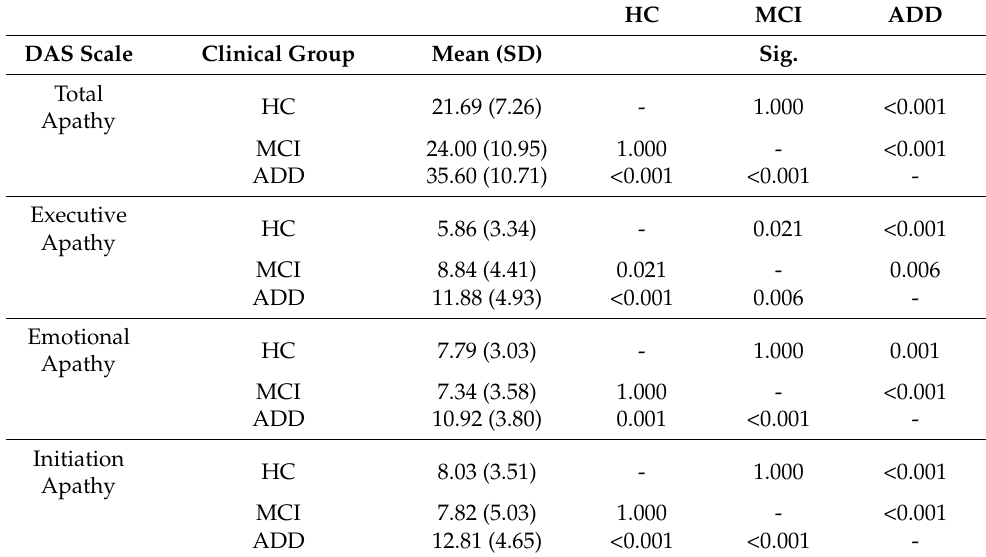
Table 4. Apathy comparisons among the different clinical